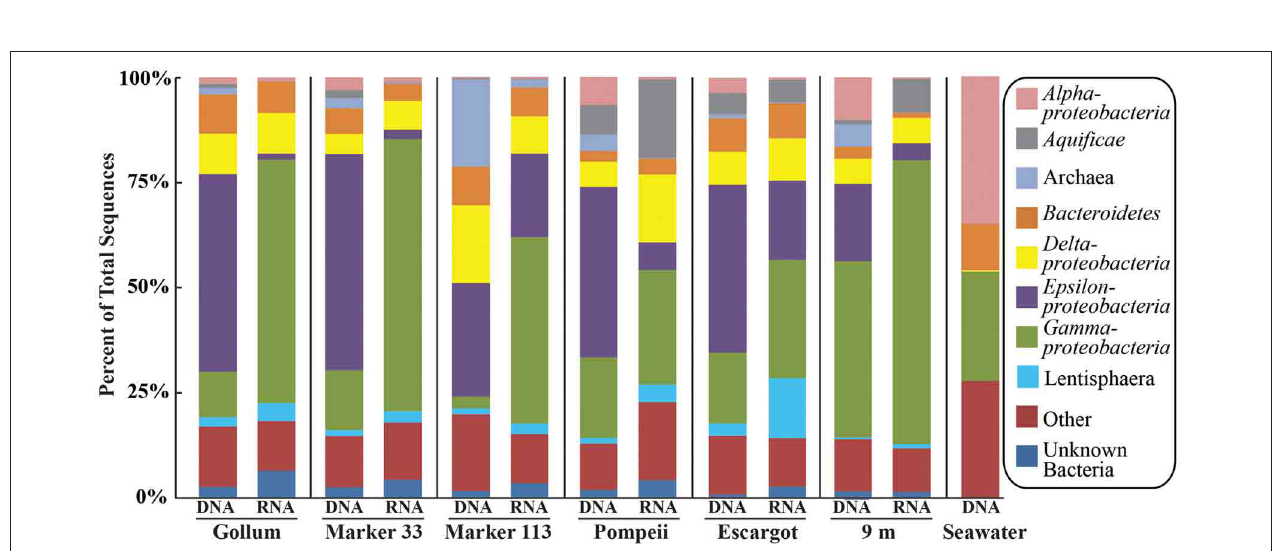
FIGURE 3 | Taxonomic breakdown and relative abundance at the phylum (and class for Proteobacteria) level for the 96% 16S rRNA gene OTUs in all samples. Only those taxa that occurred more than 3% in any individual dataset are included. Taxa that occurred less than 3% are placed into “Other.”